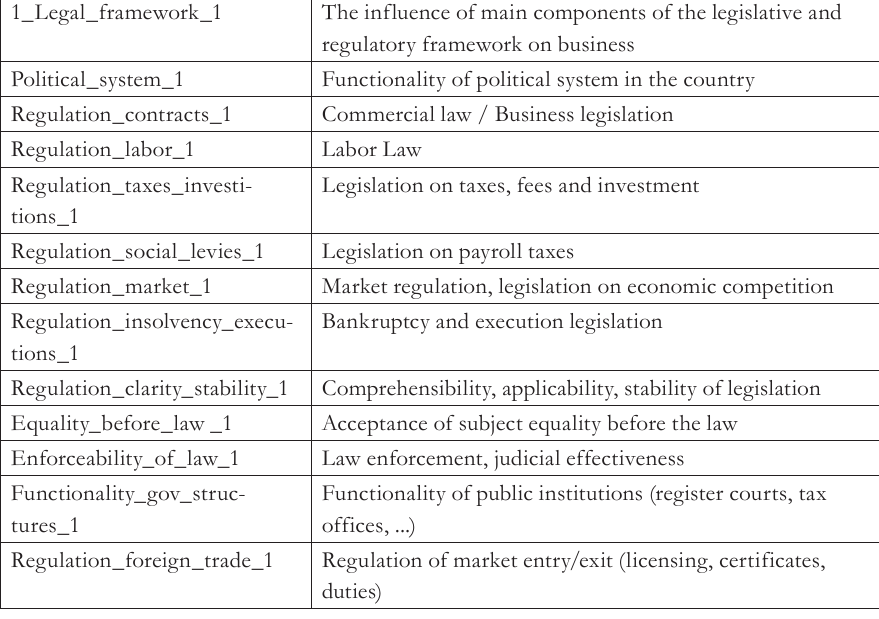
Tab. 1 – Characteristics of independent variables. Source: PAS